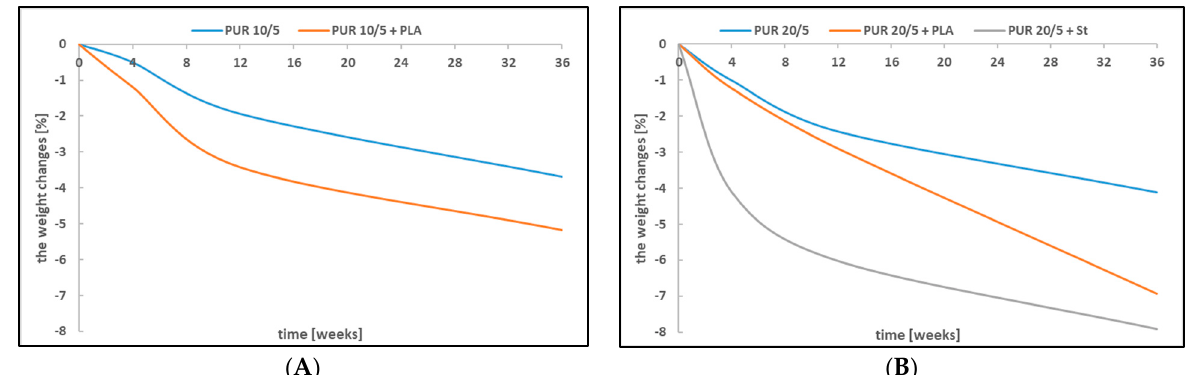
Figure 1 . The weight loss of PUR 10/5 and PUR 10/5 + PLA ( A ) and PUR 20/5, PUR 20/5 + PLA and PUR 20/5+St ( B ) samples subjected to soil burial test .